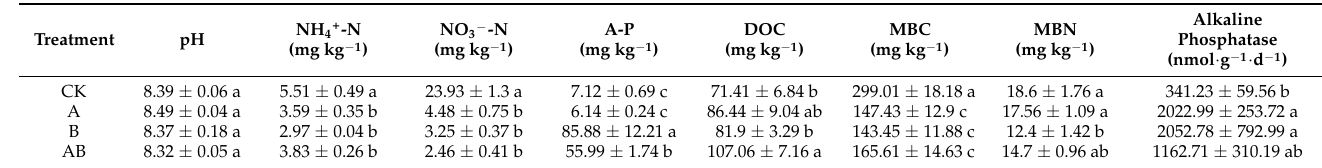
Table 3. Effects of arbuscular mycorrhizal fungi and biochar on soil properties and alkaline phos- phatase